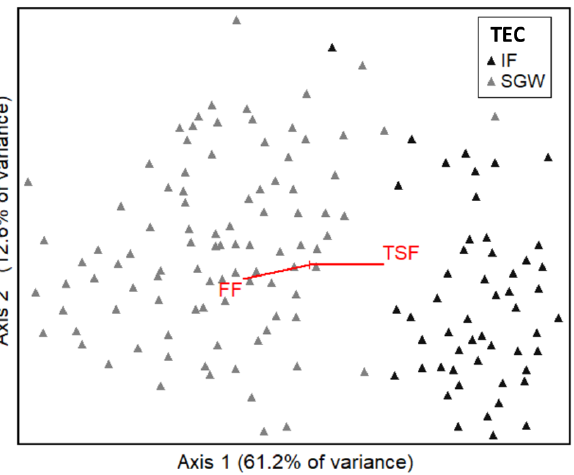
Figure 8. Non-metric multidimensional scaling plot of 160 species cover scores by 148 plots showing separation by Threatened Ecological Community (TEC) and a biplot overlay of time-since-fire (TSF) and fire frequency (FF) vectors.